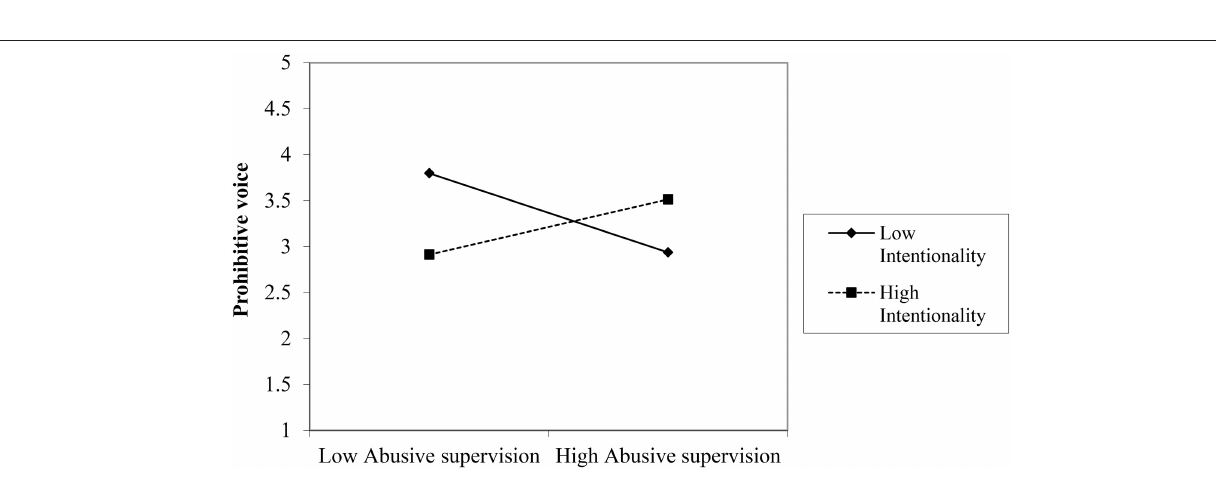
Frontiers in Psychology |